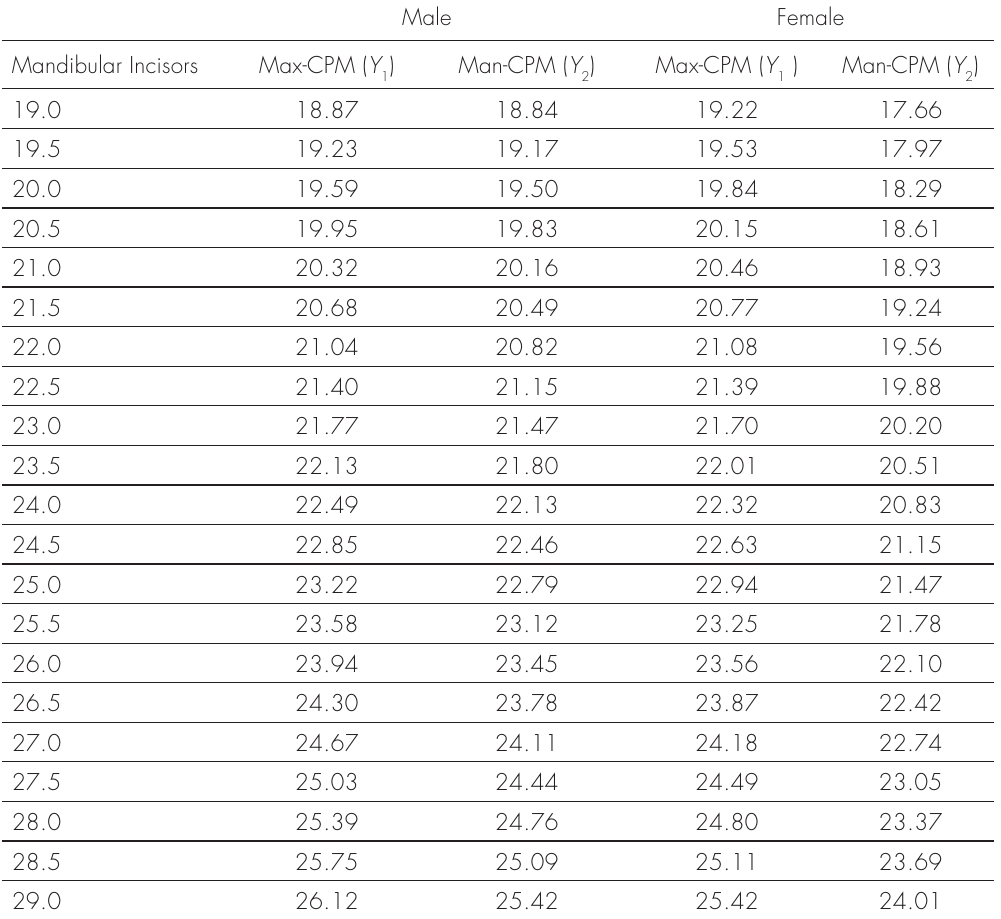
Table V. A prediction model for the estimation of mesiodistal dimensions of canines and premolars for Australian population adolescents. Male Female Mandibular Incisors Max-CPM ( Y 1